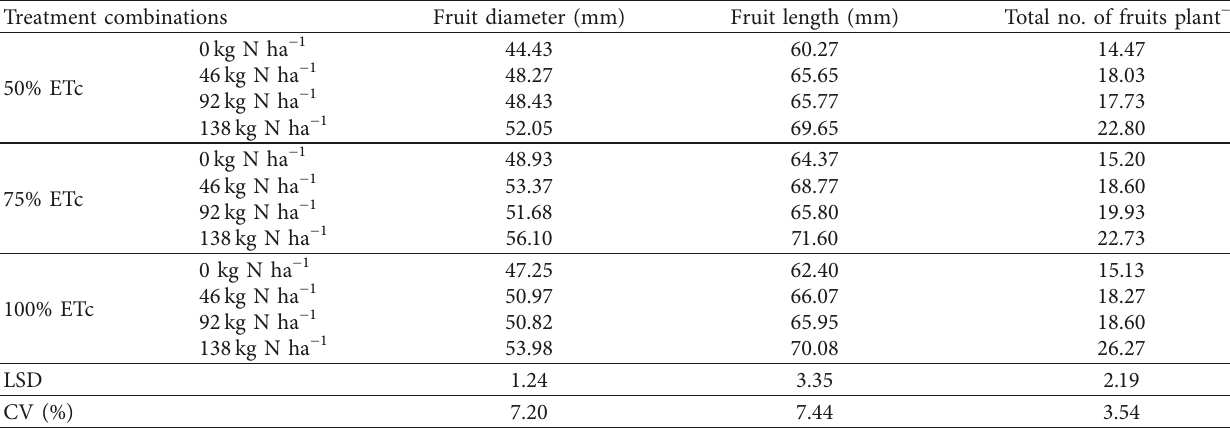
Table 1: Tomato fruit diameter, fruit length, and number of fruits per plant as affected by irrigation and N application levels. Treatment combinations Fruit diameter